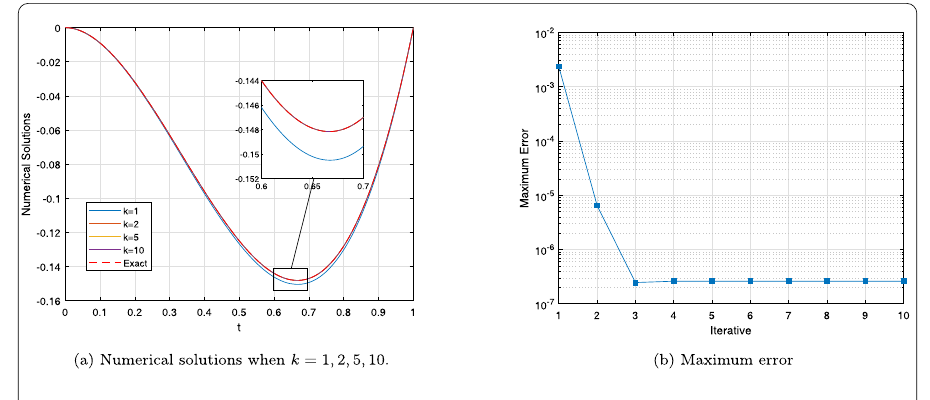
Figure 1 Numerical simulations for Example 3 using N = 2500